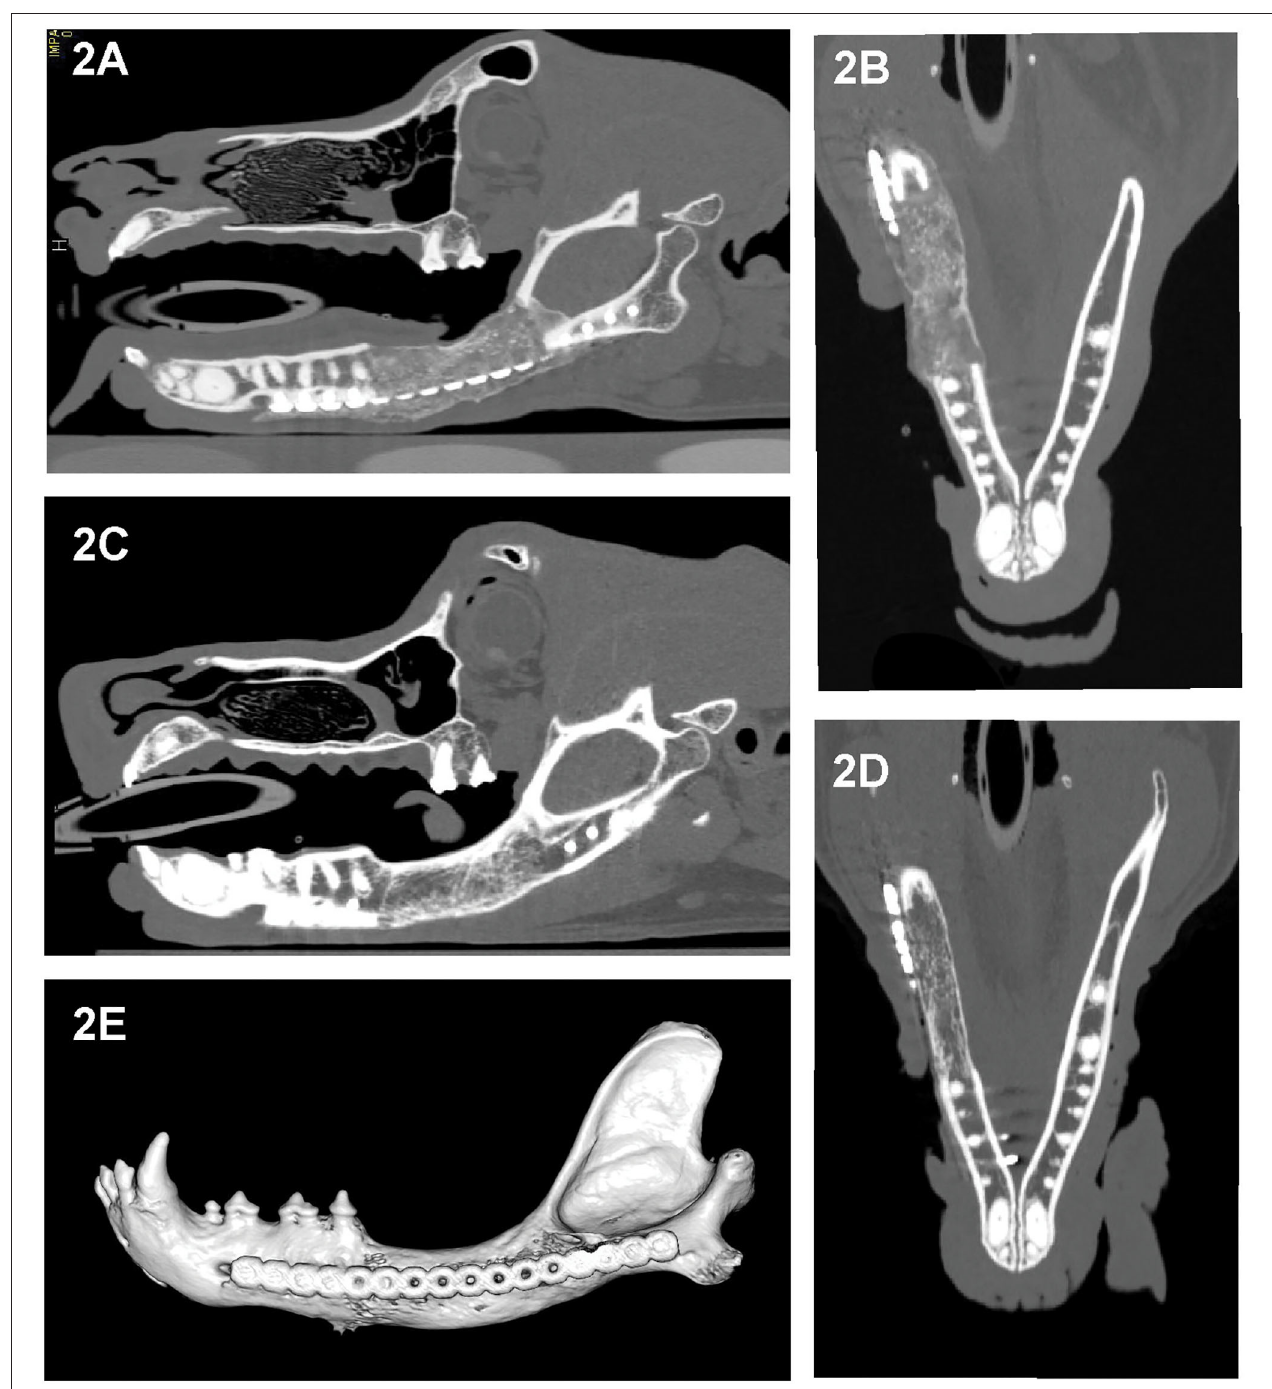
FIGURE 2 | Sagittal- and dorsal-plane reconstructed and 3D volume rendering created from the CT images of dog 5, 1 month (A,B) and 6 months (C–E) after segmental reconstructive surgery. As early as 1 month postoperatively this dog exhibited bridging new bone formation with implant material replaced by regenerated bone that is expansile and has irregular margins (A,B) . At 6 months, the regenerated bone has remodeled, exhibited smoother margins and homogeneity with barely perceptible interface with the native bone and with shape and cancellous pattern similar to the native bone (C–E) . (without failure of the construct or fracture of the regenerated used in this case series restored the dogs’ relative jaw length and bone) over a collective mean follow-up period of nearly 2 years mandibular contour, allowed all 11 dogs to resume a normal (mean, 23.1 quality of life shortly after major jaw surgery, and proved durable